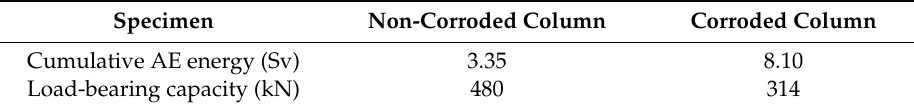
Table 4. Cumulative AE energy and bearing capacity.